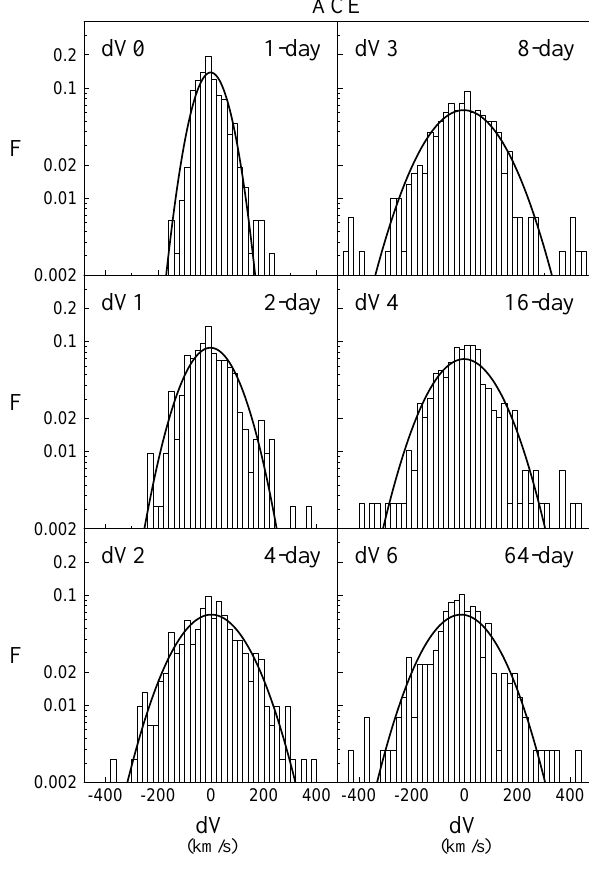
Fig. 5. Solar wind velocity ˇ and velocity differences dV 1, dV 2, dV 4, and dV 6 for the analysed ACE interval, in the same format of Fig. 3. A bar on top indicates the ACE interval that corresponds to the Ulysses VHL interval.